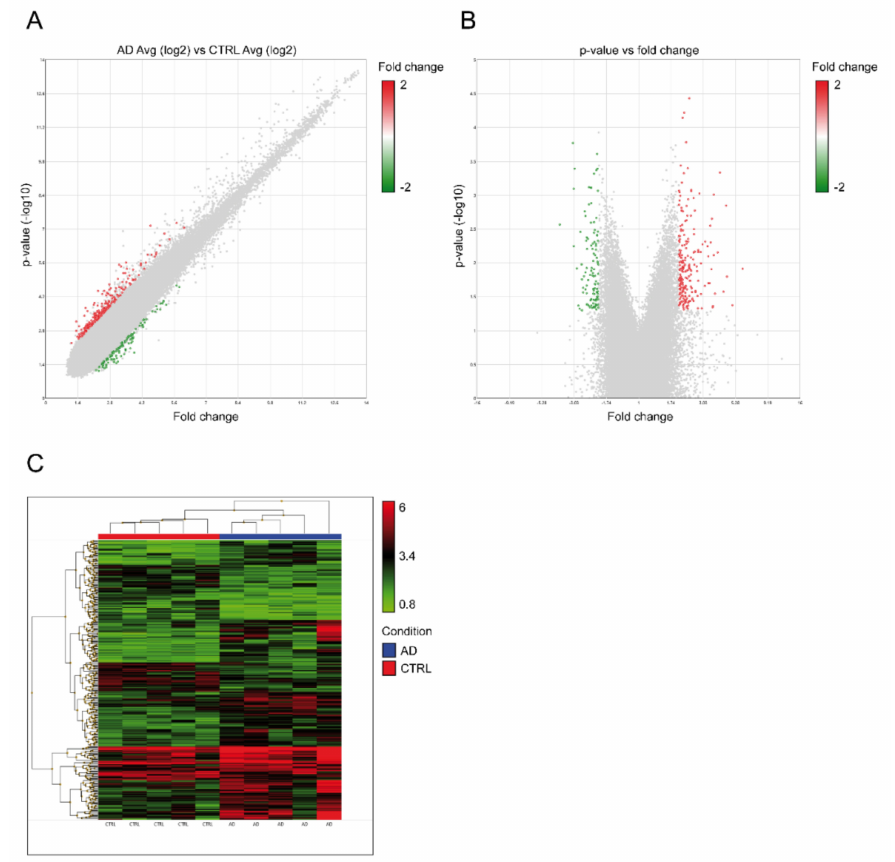
Figure 1. Results of microarray profiling. ( A ) scatter plot showing fluorescence intensity of significantly deregulated transcripts; ( B ) volcano plot showing significantly deregulated transcripts; ( C ) hierarchical clustering of analyzed samples. Legend: ( A ) and ( B ) colored dots show significantly deregulated transcripts ( p < 0.05), with red representing upregulation (fold change > 2) and green representing downregulation (fold change < − 2); ( C ) fluorescence intensity data are plotted. AD: Alzheimer’s disease patients; CTRL: una ff ected